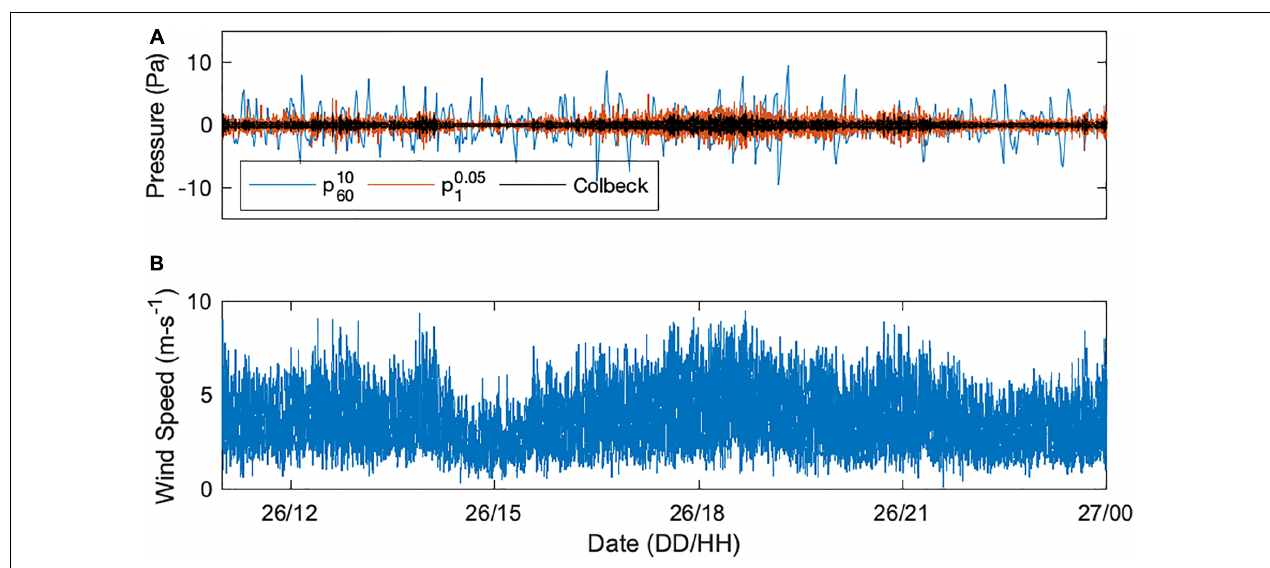
FIGURE 3 | Panel (A) shows the in-snow (12 cm depth) pressure fluctuations to wind forcing at 1.2 m shown in the bottom panel (B) for March 26, 2017 at Storm Peak Lab (case 10). In panel (A) , the blue line delineates 10 s perturbations from 1-min averages ( ρ 10 60 ), the orange line delineates 20 Hz perturbations from 1 s averages ( ρ 0 . 05 1 ) and the black line delineates the theoretical prediction from Eq. 1.